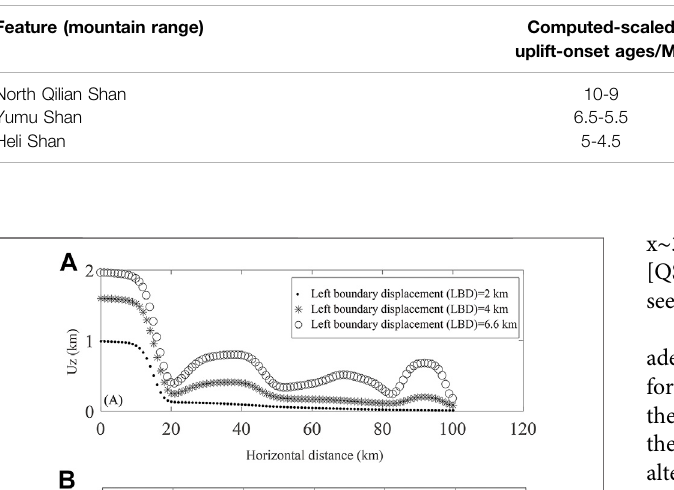
TABLE 3 | Comparison between time intervals of computed and observed topographic uplift start of features that are spatially correlated. Computed onset intervals are simply accelerating stages, whereas observed ones come from diverse geochronological estimates. In this exercise, control variable LBD has been converted to time: LBDin(0,6.6)km mappedlinearlyto(10,0)Maago,asapotentialtimescalingforreferenceandcomparison.Computedandobservedtime-ordersequencesaresame,but real onset-times of YS and HS are somewhat later (younger ages) than computed ones ( Discussion Section 4.2 ).Observations ofmountainranges ’ deformation times(and associatedfaults ’ slip-rates)arefromMétivieretal.(1998),Zhangetal.(2001),Palumboetal.(2009),Liuetal.(2010),Zhengetal.(2010),Seongetal.(2011),Zhengetal. (2013a), Chen et al. (2017), Zheng et al. (2017), Hu et al. (2019), and Yang et al. (2020).